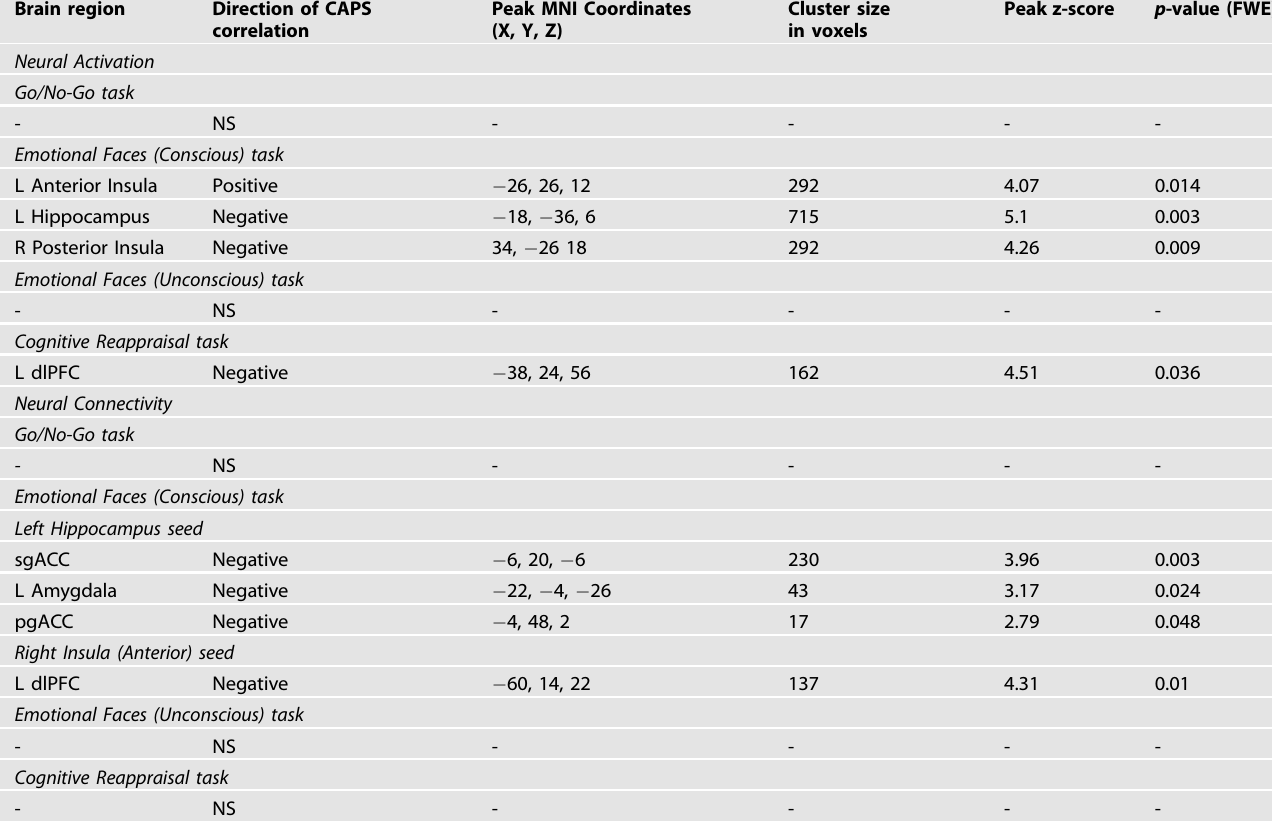
Table 2. Summary of signi fi cant associations of changes in neural activations and connectivity with reduction in PTSD symptoms. Brain region